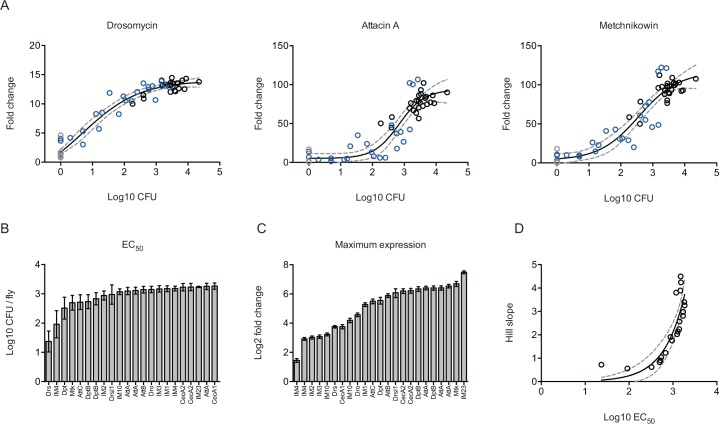
Antimicrobial peptide expression dynamics.(A) AMP dose response curve. Expression of AMPs was determined by microarray. Fold change is plotted relative to log microbe load (grey: uninfected control, black: infected, no treatment, red: infected, ampicillin treatment). The data are fit with a four-parameter sigmoid model. Adjusted r2: Drosomycin = 0.9521, Attacin A = 0.8509, Cecropin A = 0.8933. The dotted lines indicate the 95% confidence interval. (B) EC50 of antimicrobial peptides. Error bars mark the 95% confidence interval. (C) Maximum expression level of antimicrobial peptides. Error bars mark the 95% confidence interval. (D) Relationship between Hill slope and EC50. The data are fit with an exponential growth function with an adjusted r2 = 0.5126. Data are reported in S1 Data.